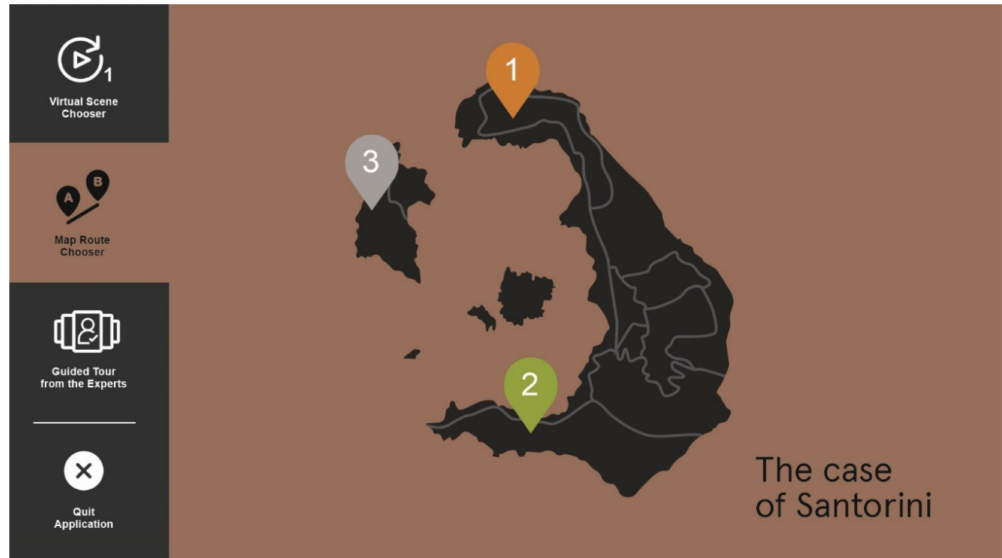
Figure 12. User Interface of Virtual Scene Chooser (screenshot): The user can choose between di ff erent scenes through a quick